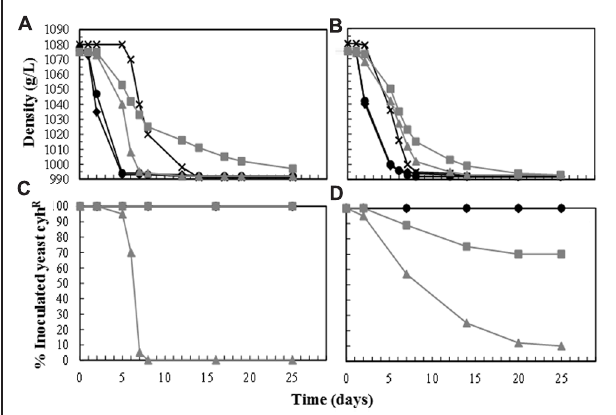
FIGURE 2 | Must fermentation kinetics and yeast population dynamics of two independent sets of vinification trials done with two Macabeo grape musts ( < 100 NTU, pH < 3.5) in 2011 (A,C) and 2012 (B,D). Each yeast was single inoculated in the fresh must at a cell concentration of 2–4 × 10 6 CFU/mL for the S. cerevisiae strains E7AR1 (K2, cyh R ) or EX85R (non-killer, cyh R ), and 2–4 × 10 7 CFU/mL for T. delbrueckii strains EX1180-11C4 (Kbarr-1, cyh R ) or EX1180-2K − (non-killer, cyh R ). (A,B) Evolution of must-wine density. (C,D) Evolution of the percentage of each inoculated yeast (cyh R ) during the must fermentation. Symbols: Non-inoculated control (- × -), E7AR1 (- ◆ -), EX85R (- ● -), EX1180-11C4 (- (cid:2) -), and EX1180-2K − (- (cid:3) -).